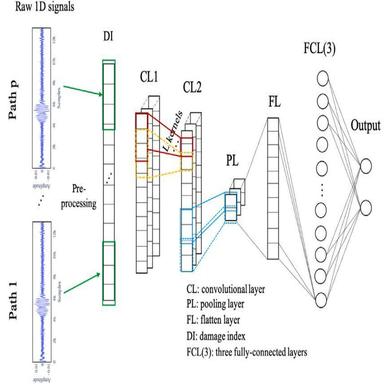
Architecture of 1DCNN with multiple 1D signals used as input.